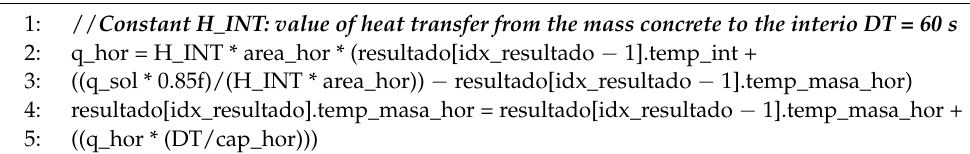
Algorithm 7 calculates the concrete temperature in order to obtain the heat obtained from the exterior wall through solar radiation. Algorithm 7. Compute mass concrete temperature